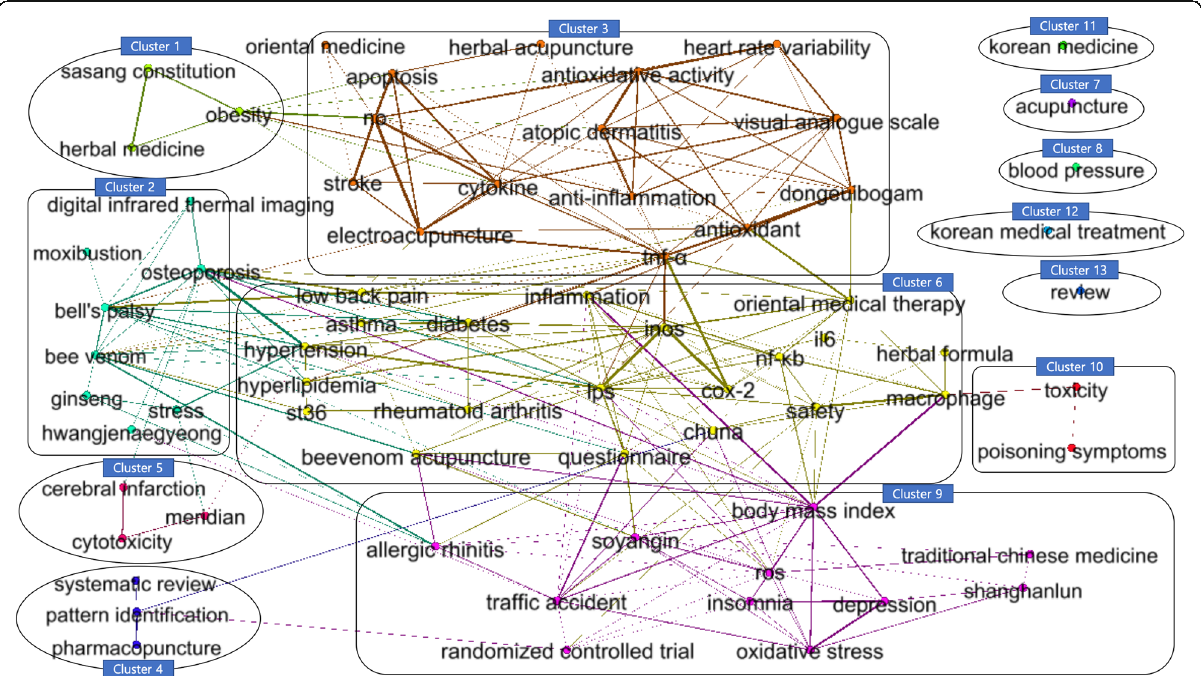
Fig. 3 Thirteen groups of research topics. The network consists of 70 nodes and 245 edges, which are clustered into nine groups using the MCL algorithm. Abbreviations: il6 (interleukin 6); inos (inducible nitric oxide synthase); lps (lipopolysaccharide); nf- κ b (nuclear factor kappa-light-chain- enhancer of activated B cells); ros (reactive oxygen